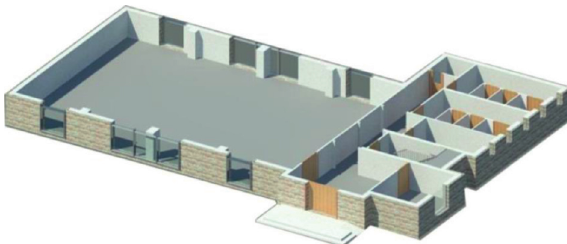
Figure 13: Perspective plan of Ras Alain Multipurpose Hall.